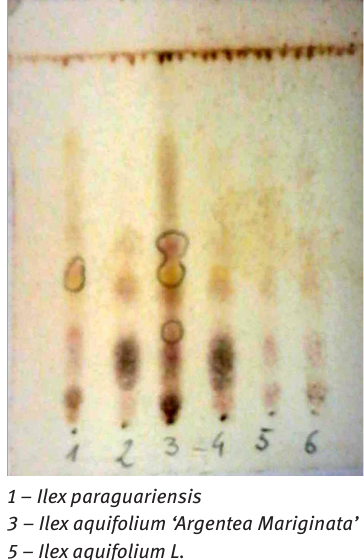
Figure 2: TLC of Ilex